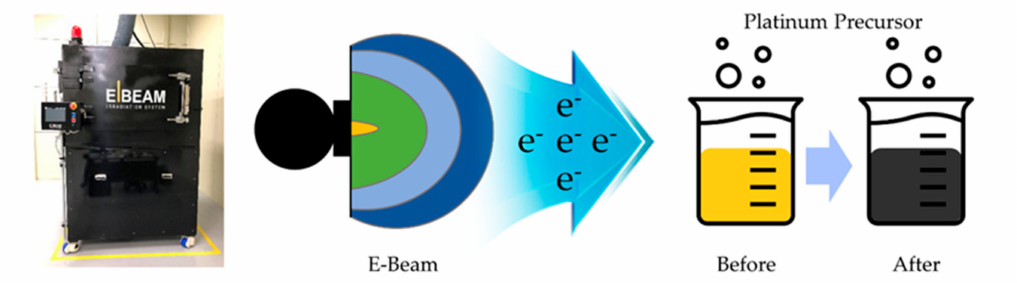
Figure 1. Photograph of the compact electron beam (E-Beam) generator used and schematic illustration showing the reduction of Pt precursors by irradiation of a low-energy electron